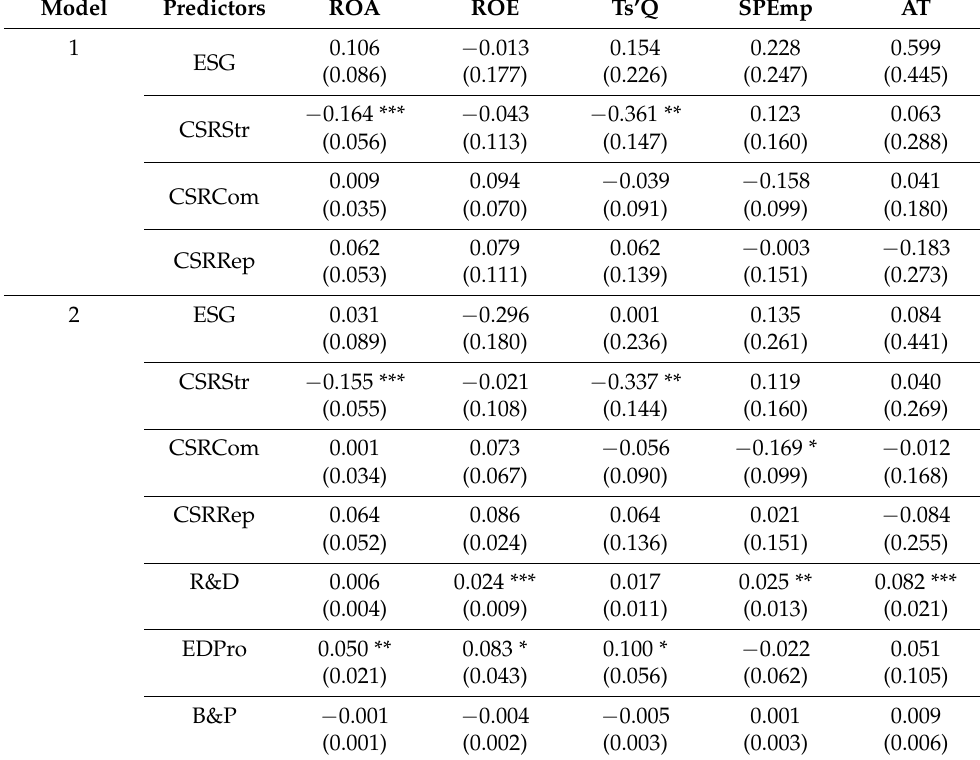
Table 8. Econometric